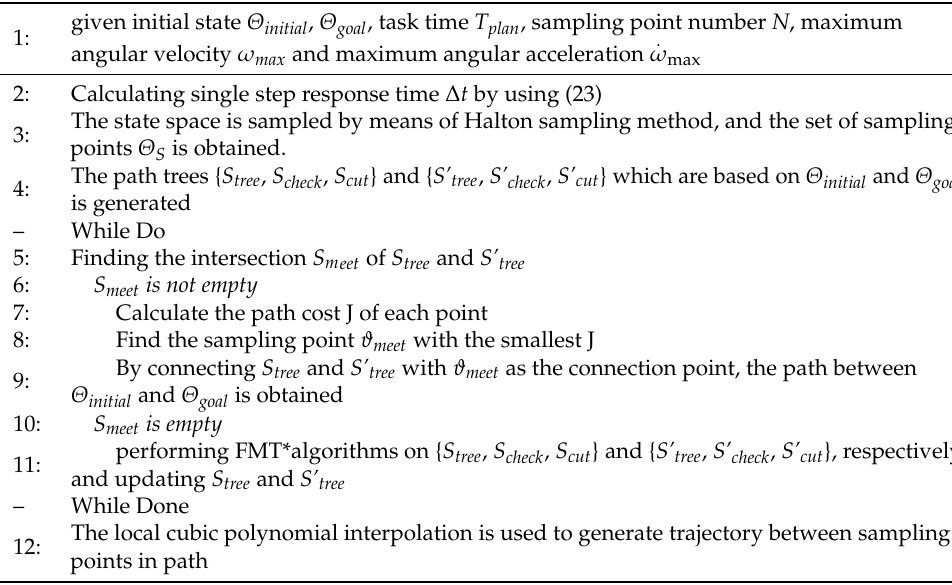
Table 3. Manipulator path planning based on the Bi-FMT* algorithm.